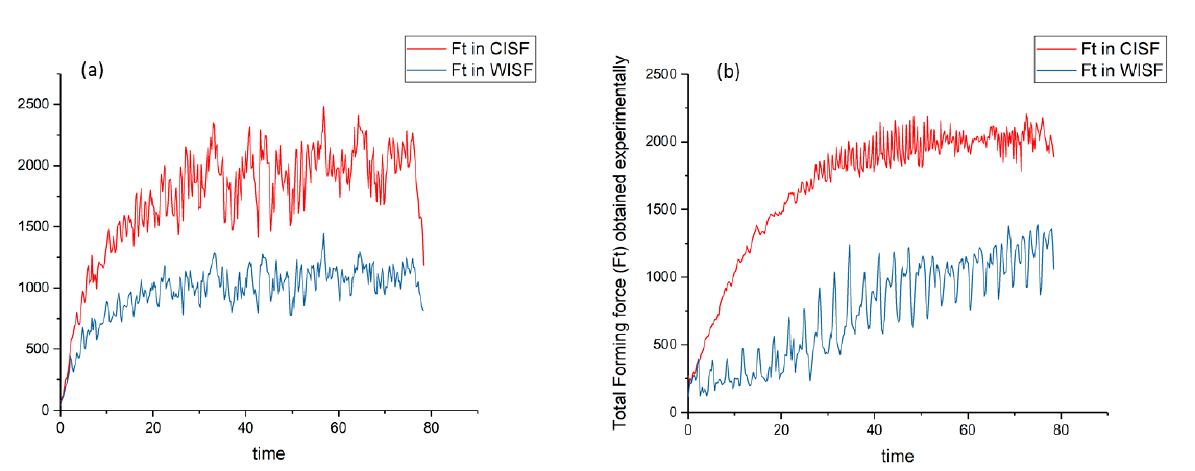
Figure 12. Comparison of total forming force: ( a ) comparison of F t in FEA modeling and ( b ) com- parison of F t obtained experimentally.